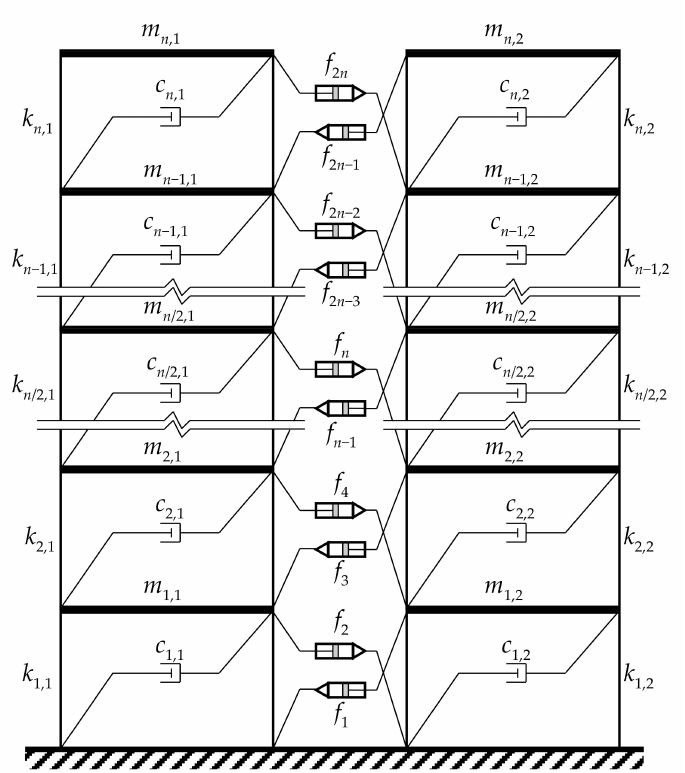
Figure 1. Structural model of dynamically similar buildings connected with MR dampers in Configu- ration